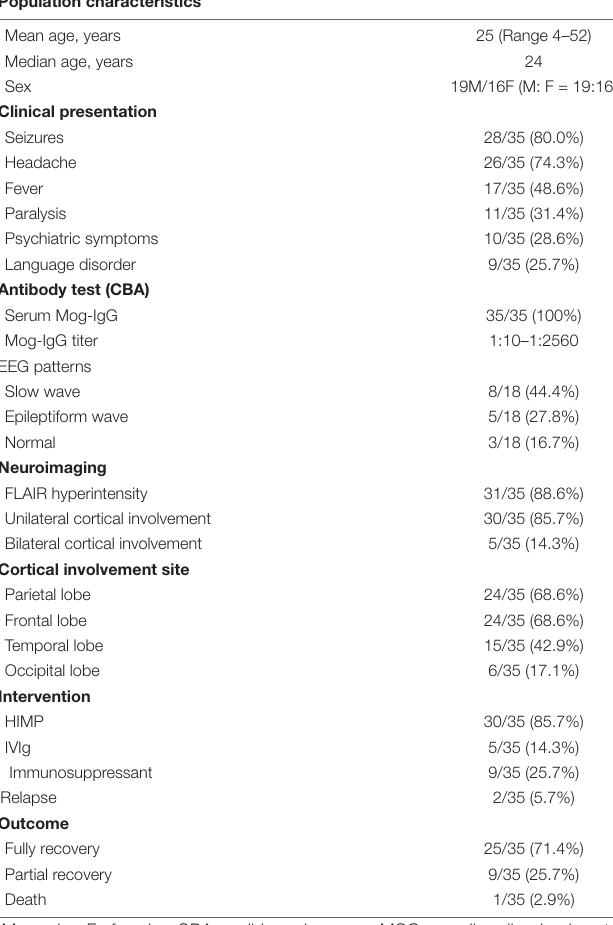
TABLE 2 | Main demographic data, clinical characteristics, laboratory, and imaging results in described MOG-Ab associated cerebral cortical encephalitis. Population